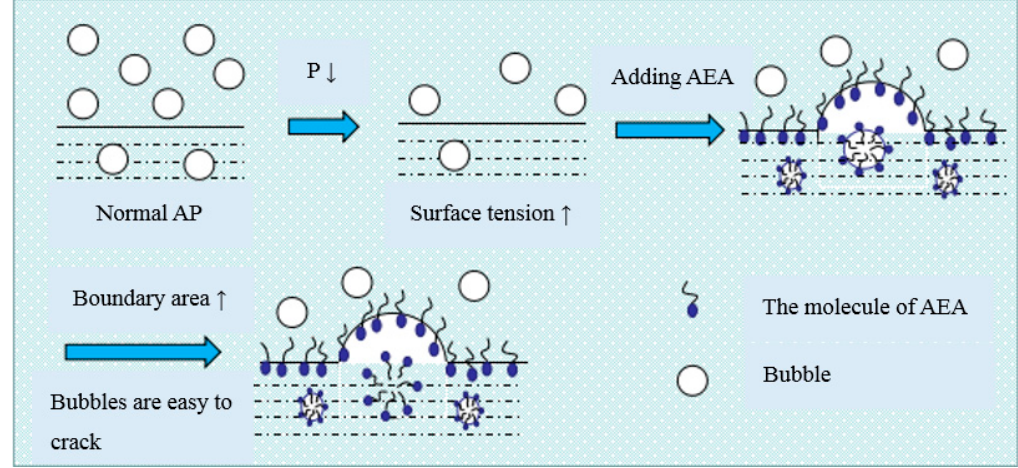
Figure 2. Schematic diagram of bubble crack.